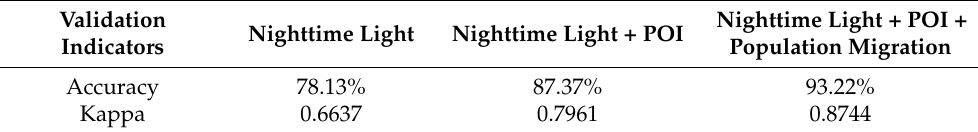
Table 3. The validation result of urban center identification in the